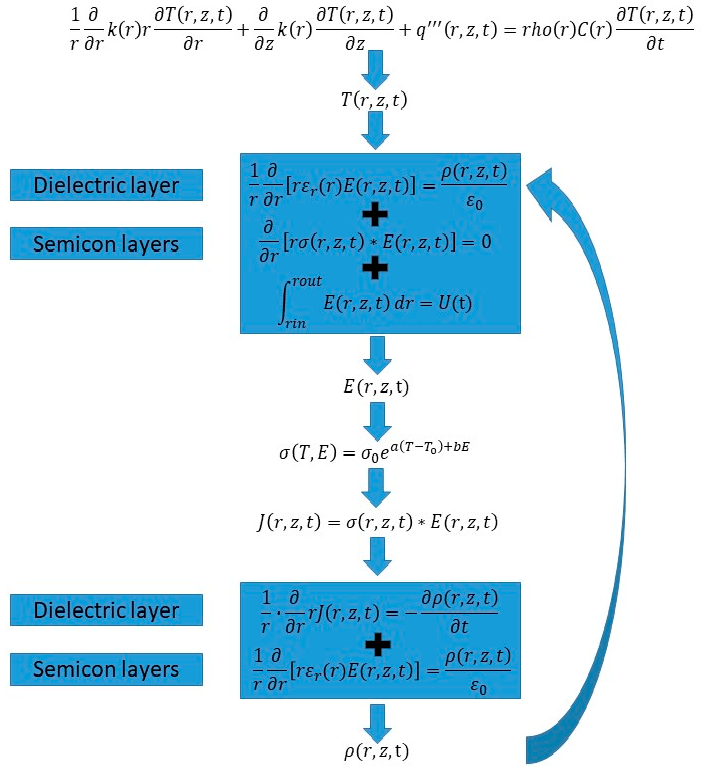
Figure 3. Scheme of the calculation model.